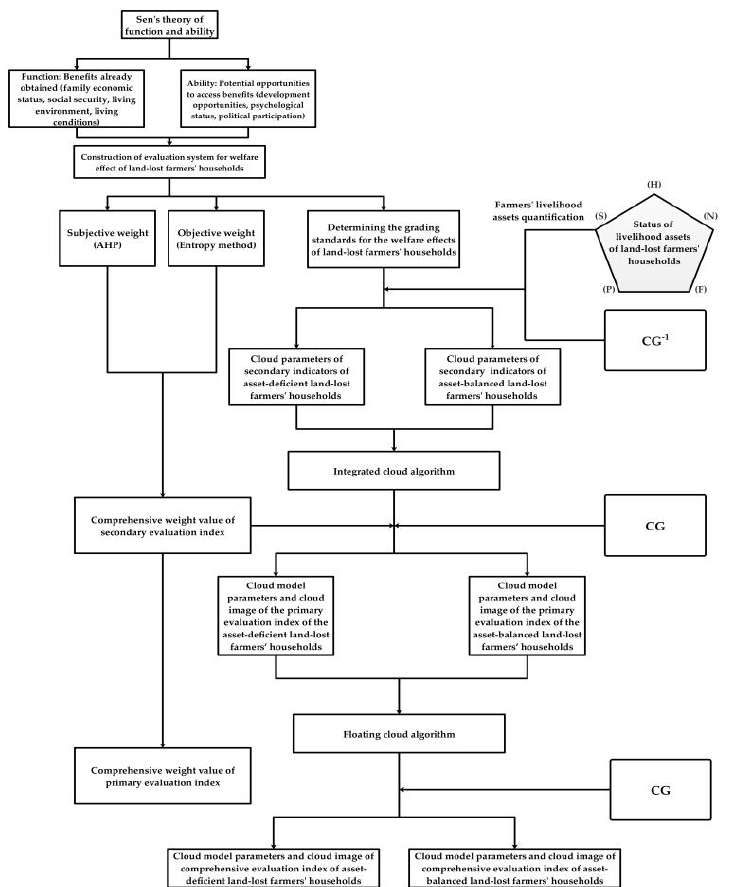
Figure 7. Evaluation of the welfare effects of land-lost farmers' households under different livelihood asset allocations.